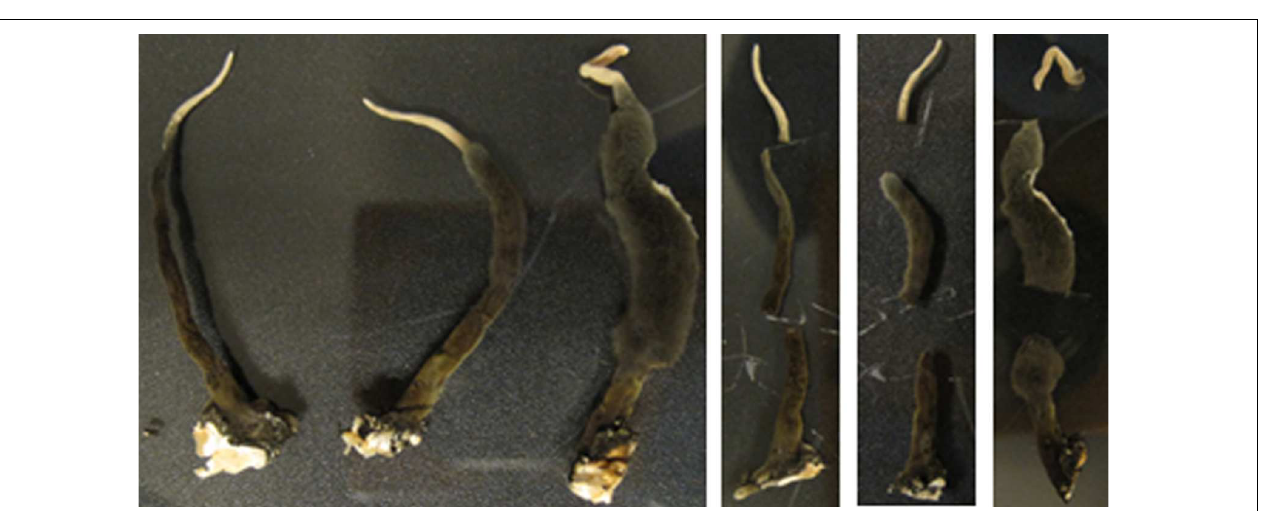
FIGURE 3 | A representative group (Group 3) of three stroma and their respective segments. Each segment ranged from 9 to 20